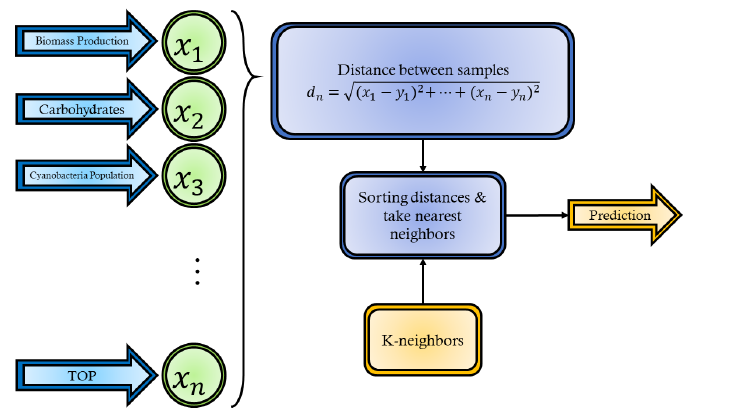
Figure 5. kNN flow representation for regression